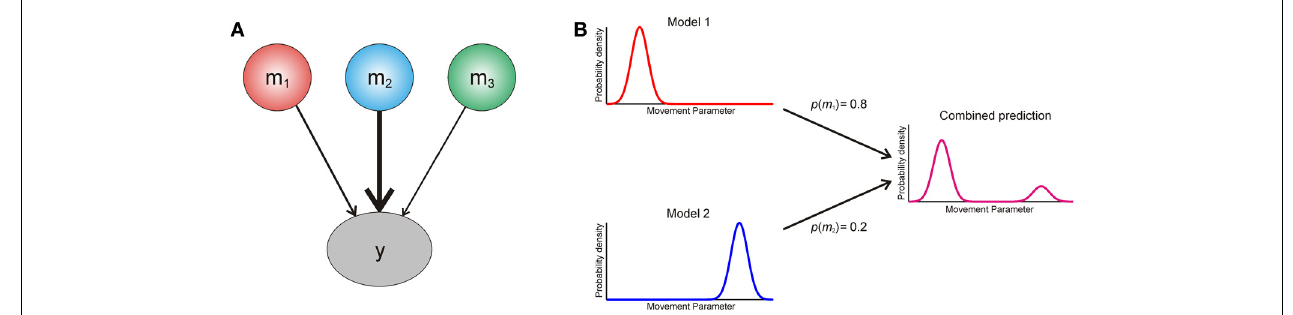
FIGURE 2 | (A) Graphical illustration of Bayesian model averaging. To generate a single Bayes optimal prediction about data y , the predictions of three models m 1 − 3 are weighted according to their posterior probabilities [see Equation (A5)]. Here model two has the largest posterior probability, and thus its prediction is weighted most strongly. (B) Cartoon explaining interference effects using model comparison. An